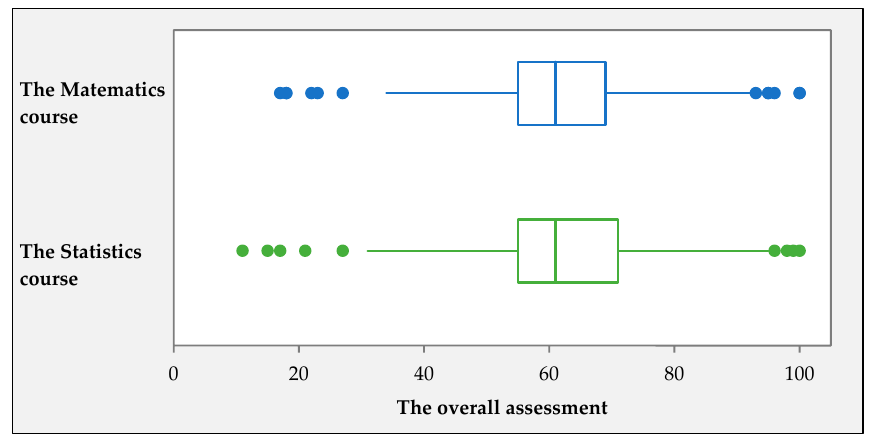
Figure 7. The box plots of the overall assessments of the Mathematics course and the Statistics course. Table 3. Overview of student success rates in individual years of study.